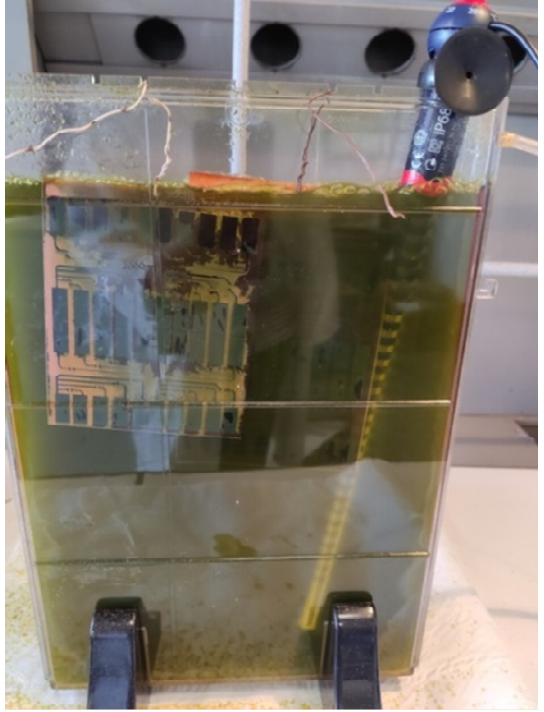
Figure 2. Vertical Etching